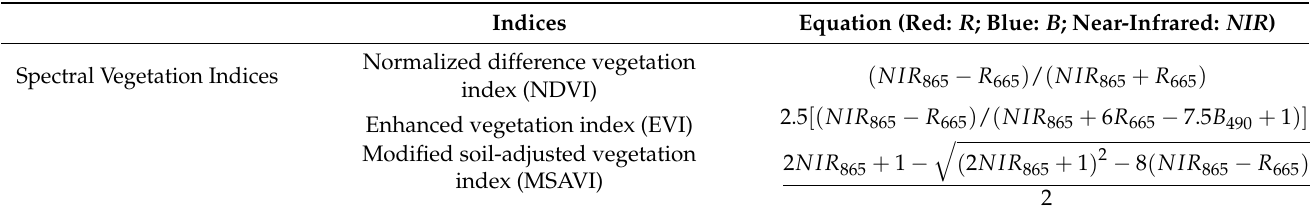
Table 3. The spectral indices used in this study. Indices Equation (Red: R ; Blue: B ; Near-Infrared: NIR ) Normalized difference Spectral Vegetation Indices